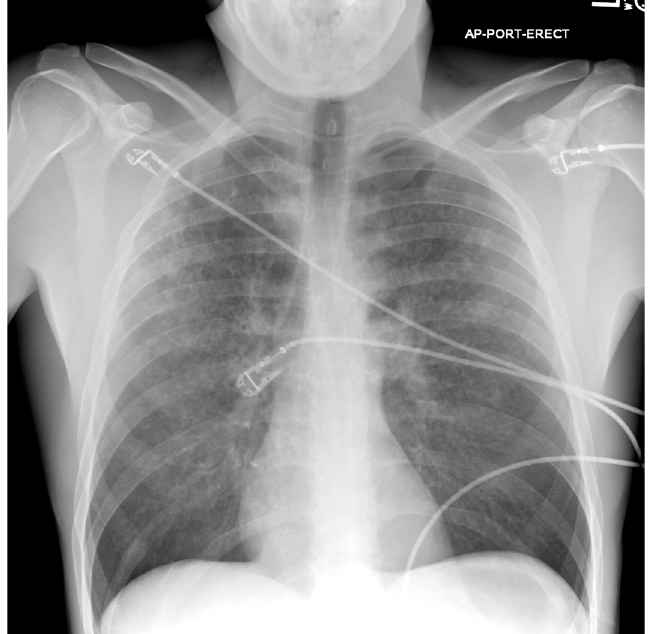
Figure. Chest radiography showing diffuse bilateral patchy infiltrates 60 minutes after propofol